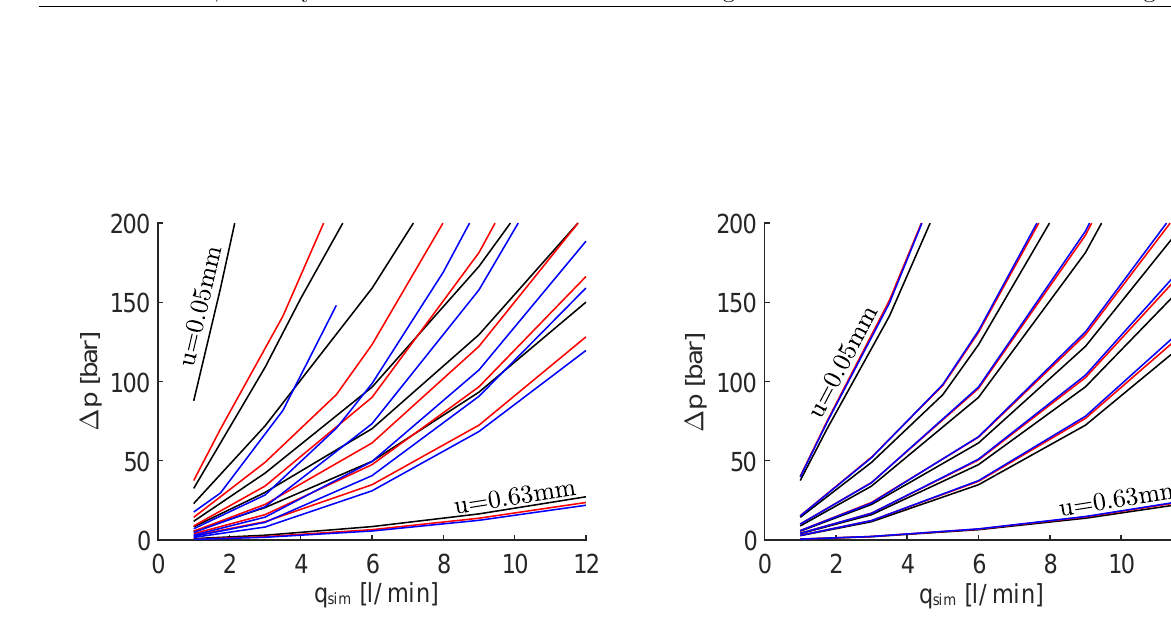
Figure 7: ∆ p ( q sim ) for HV at 20(black), 40(red), Figure 8: ∆ p ( q sim ) for HV(black) HEES(red)